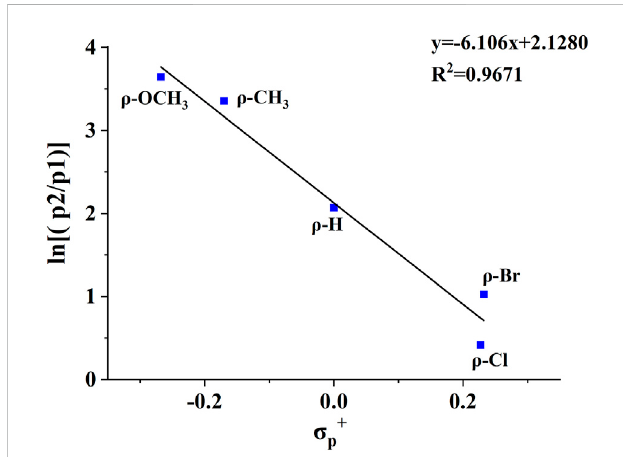
FIGURE 4 The plot of ln [( p2 )/( p1 )]vsthe σ p + substituent constants for the CID reactions of compounds 2, 4, 5, 6,